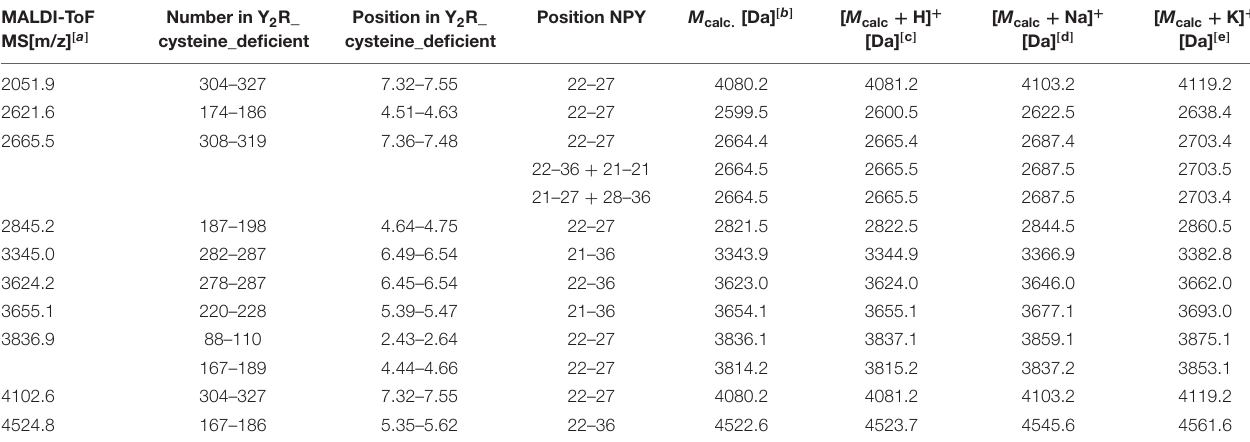
TABLE 5 | Signals of photo-crosslinked Y 2 R_cysteine_deficient with [K 22 [(Ahx) 2 -biotin]Bpa 27 ]NPY identified by MALDI-ToF mass spectrometry that correlate with the calculated masses of photo-crosslinked fragments of Y 2 R_cysteine_deficient with [K 22 [(Ahx) 2 -biotin]Bpa 27 ]NPY and [K 22 [(Ahx) 2 -biotin]Bpa 27 ]NPY with itself and are found in at least two independent